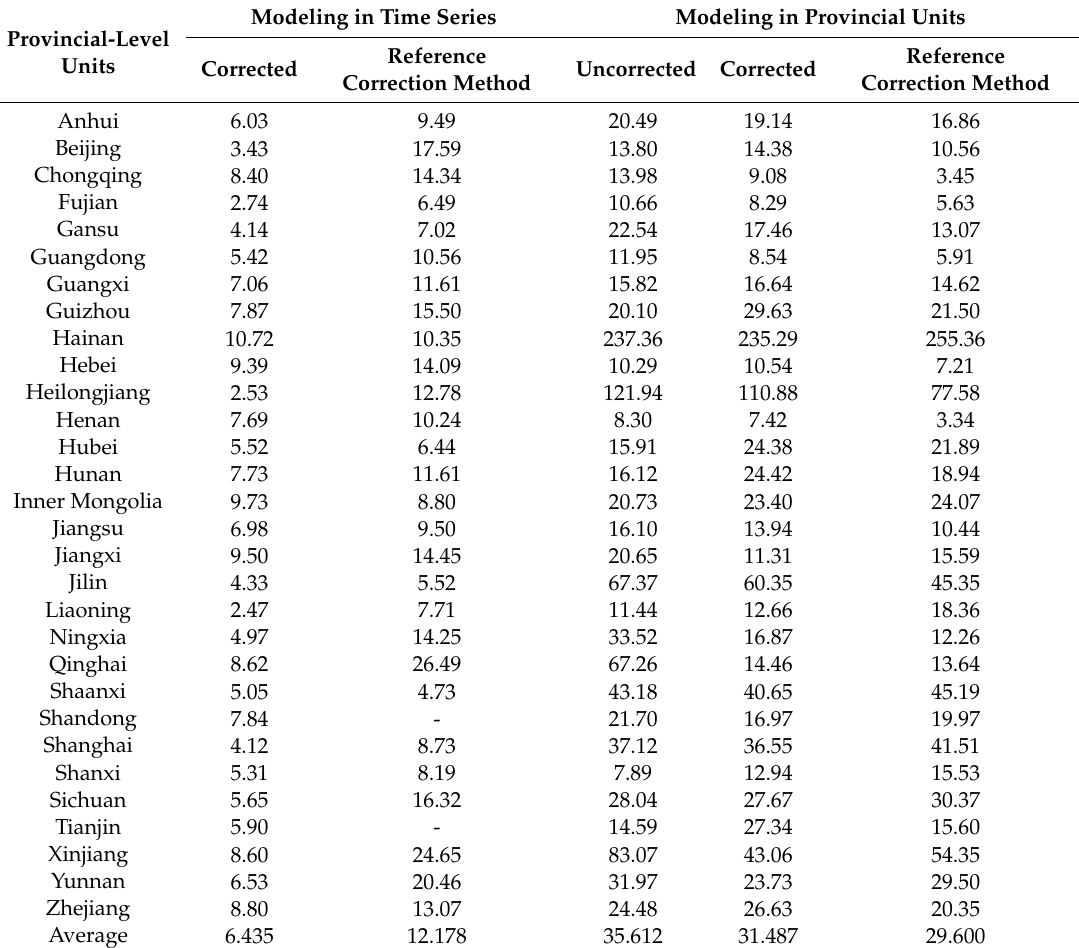
Table 13. MARE of the predicted electric power consumption (EPC) in time series and in provincial units.